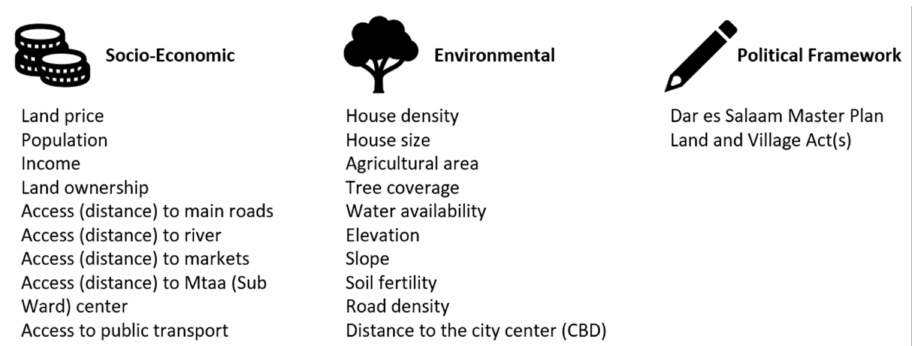
Figure 5. Set of indicators to characterize the peri-urban, with regard to sustainability pillars. Socio- economic indicators include social and economic indicators, as well as accessibility; environmental includes ecological factors and conditions including land cover; the political framework refers to planning guidelines of land